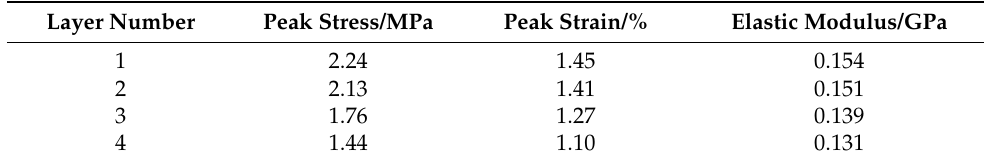
Table 6. Mechanical parameters of layered cemented filling